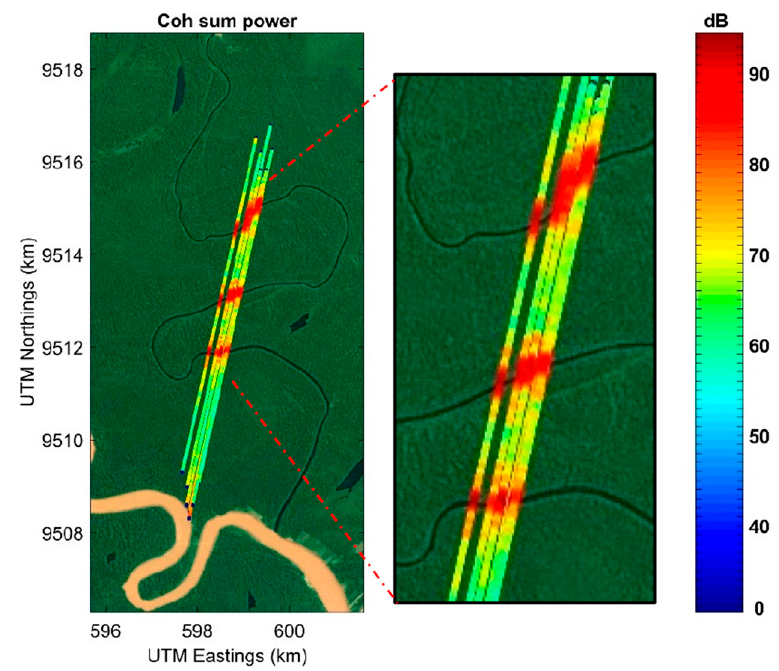
Figure 11. Amplitude profiles of the 8 passes used in this case study (Rio Nahuapa).